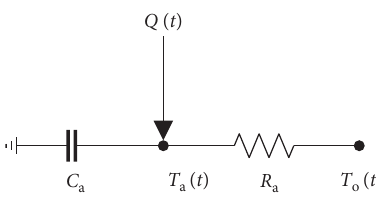
Figure 2: equivalent thermal parameter model of single air conditioner.